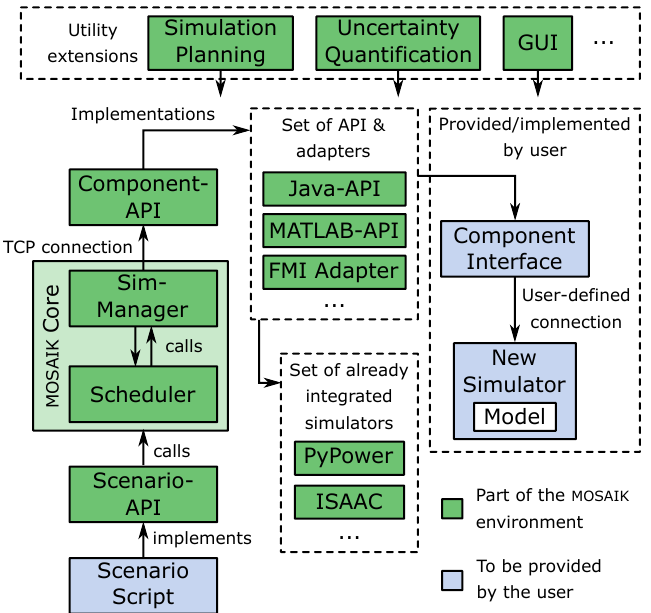
Figure 1. Architecture overview of the full MOSAIK